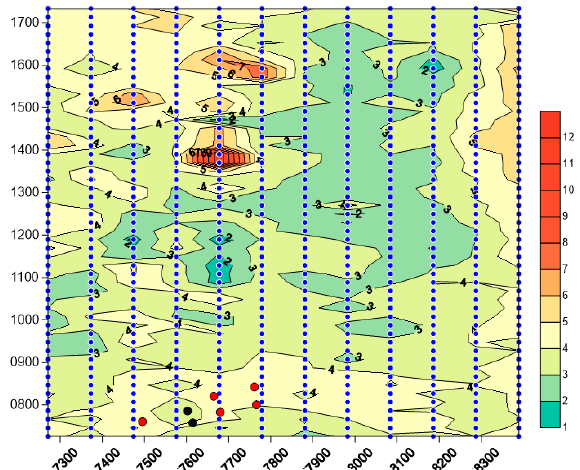
Figure 9. The nearest neighbor interpolation contour map. The red and black symbols are the logging well with and without gold mine, respectively.